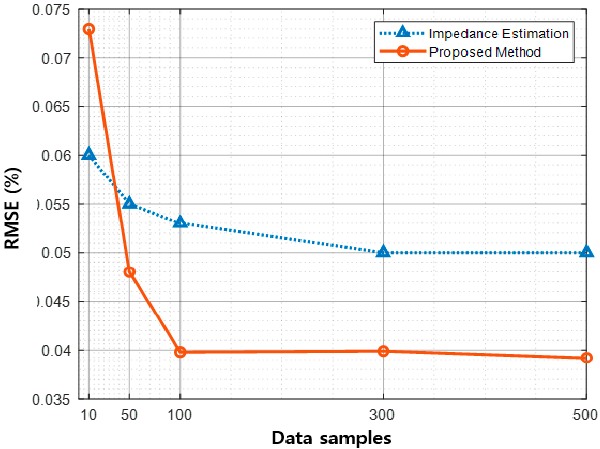
Figure 14. Effect of the data sample on the voltage prediction at 1.0 (p.u) slack node voltage.